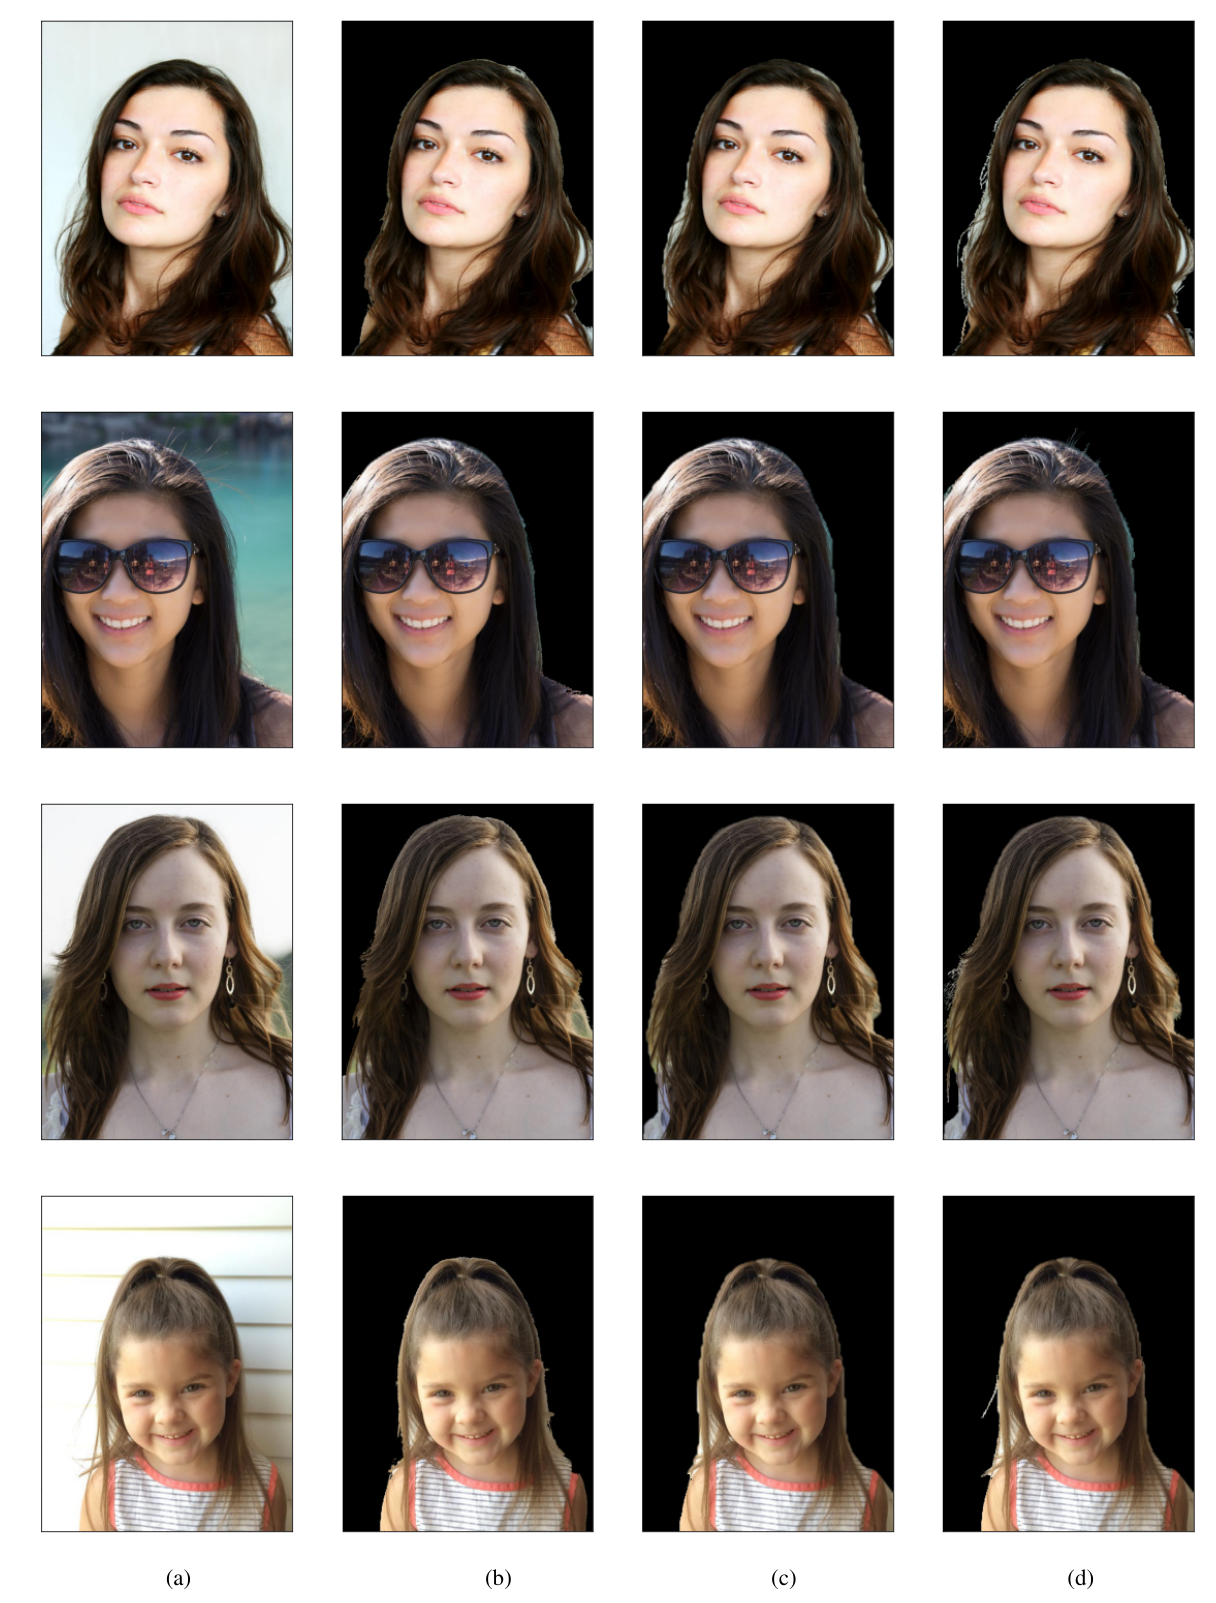
Figure 7. Examples of segmentation:(a) the original image; (b) the ground truth segmentation ; (c) the foreground segmentation by the neural network; (d) the proposed segmentation using the neural network and principal curvatures